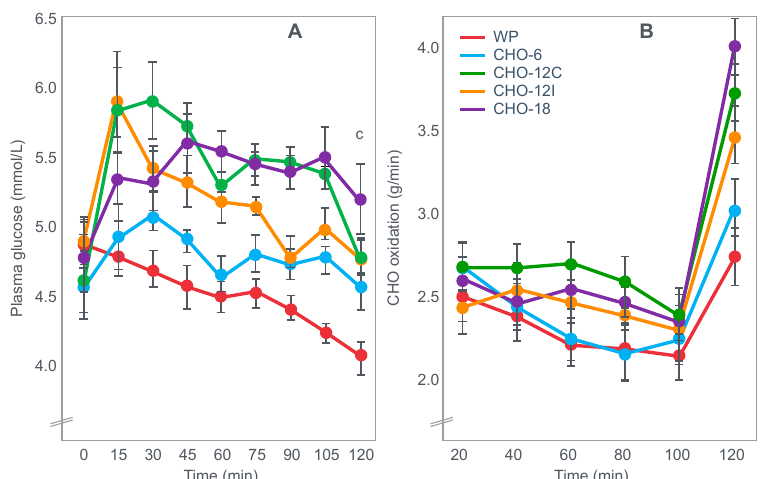
Figure 21. Changes in plasma glucose concentrations (panel A ) and in rates of carbohydrate oxidation (panel B ) when subjects drank either placebo or one of four different carbohydrate solutions with different carbohydrate concentrations (6, 12 or 18%). CHO-12C and CHO-12I refer to trials that were conducted continuously (C) or intermittently (I). Adapted with permission from ref. [51]. Copy-right 1989 American Physiological